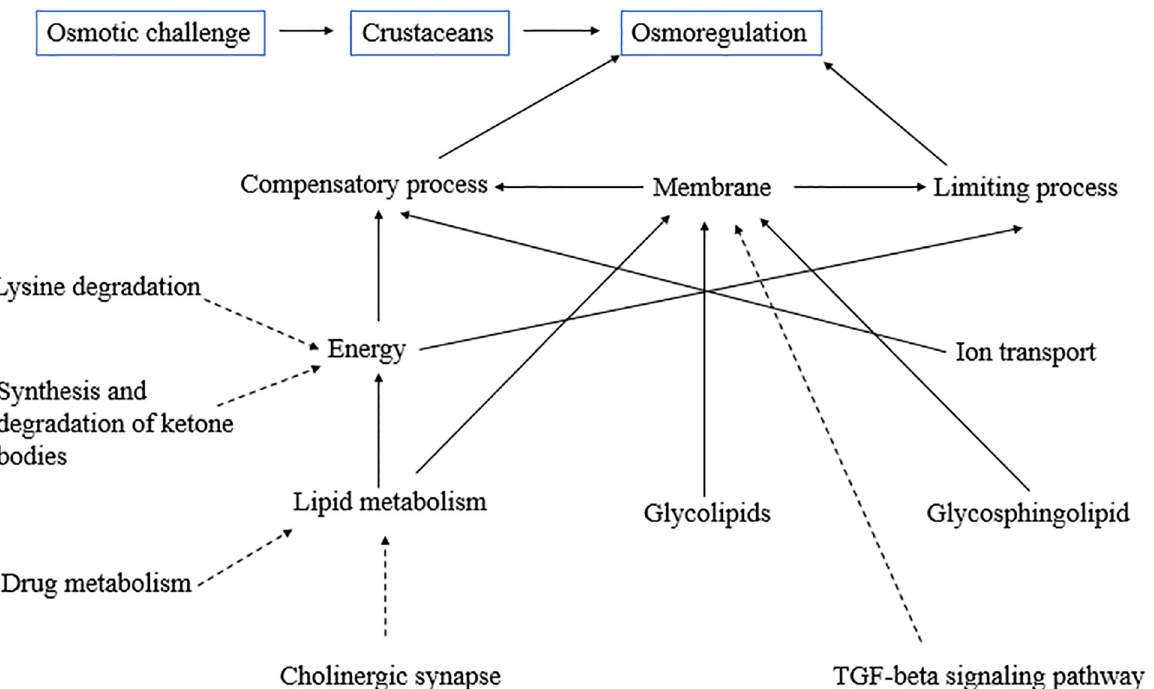
Fig 7. Relationship between the most influenced pathways and osmoregulation. The dotted-line arrows are indirect effects, and solid-line arrows indicate direct influence.